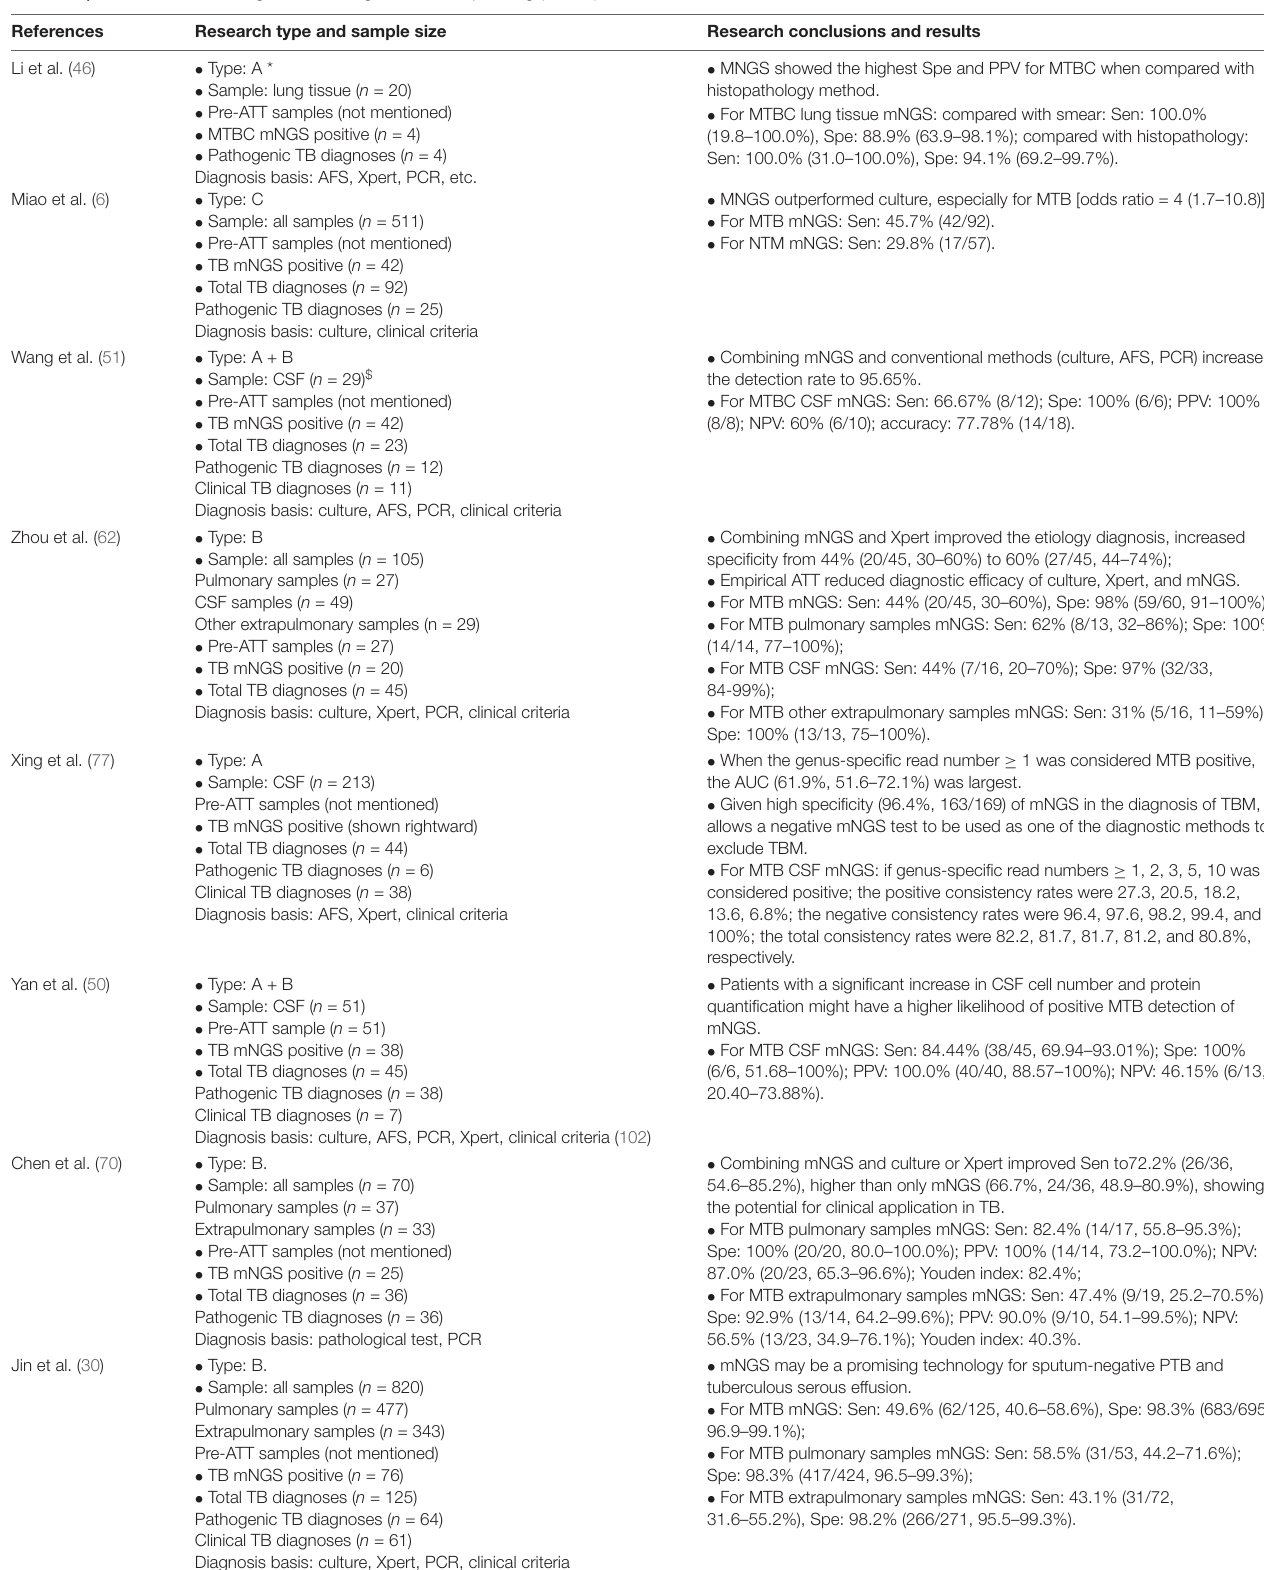
TABLE 2 | Effectiveness of metagenomic next-generation sequencing (mNGS) for MTB